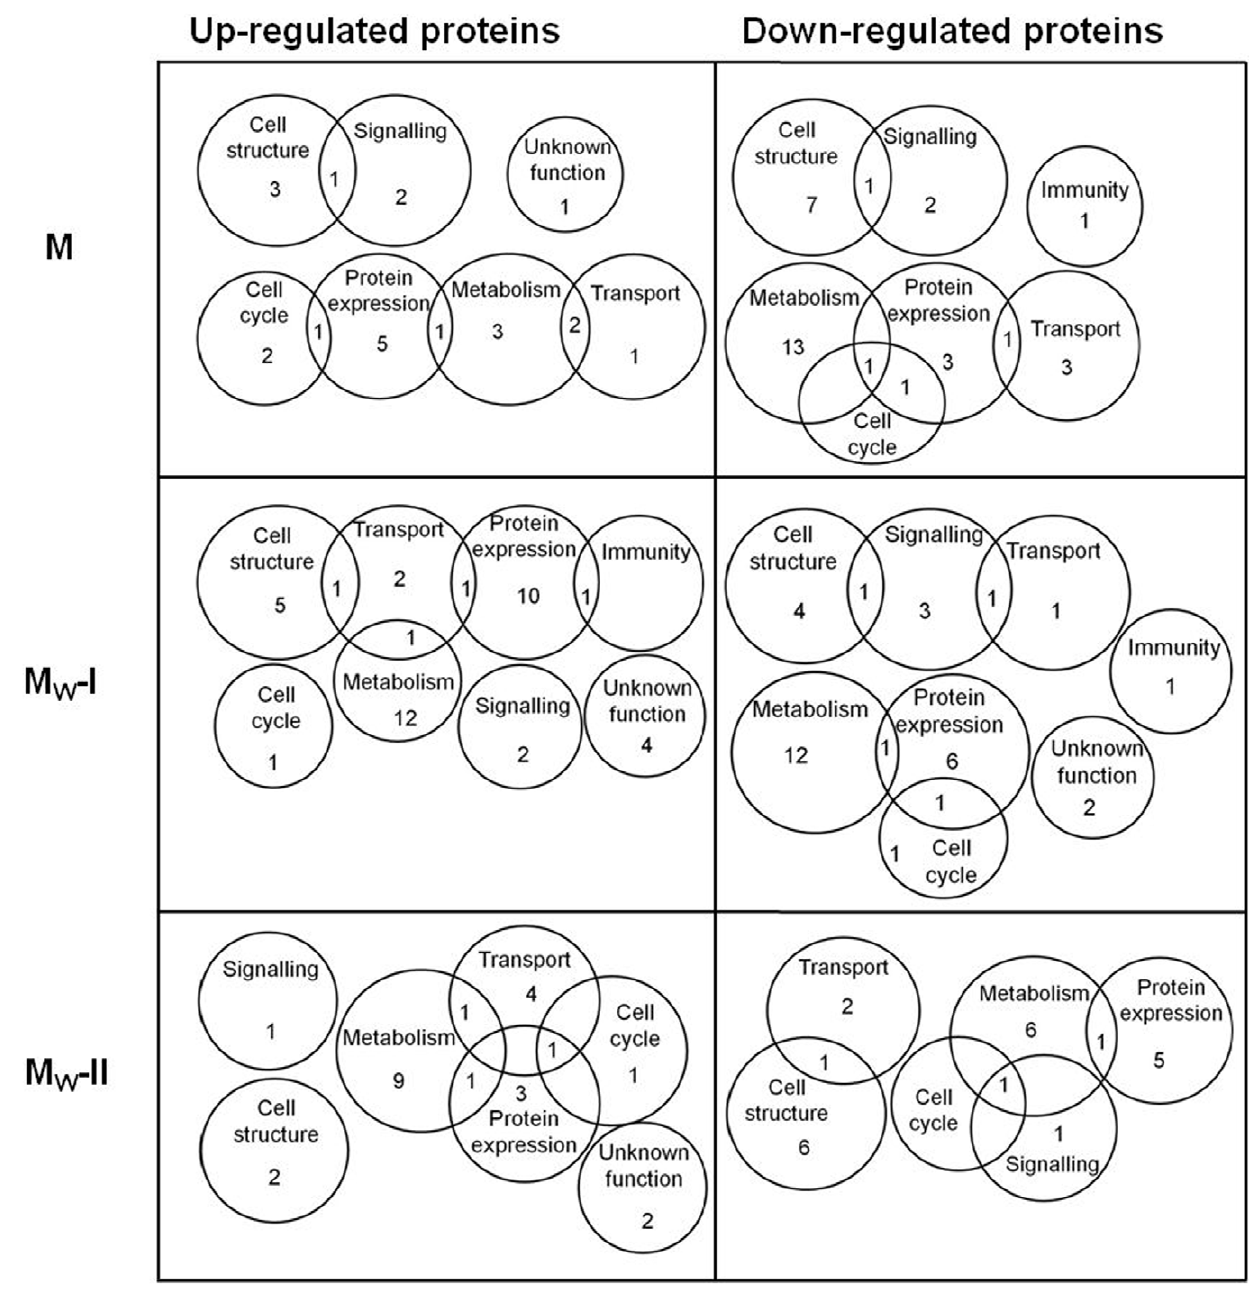
Figure 3. Venn diagrams showing the distribution of myocardial proteins in the cytosolic fraction altered by morphine treatment and withdrawal. Numbers in the individual circles or sectors refer to the number of altered proteins which were determined in the cytosolic fraction isolated from the left ventricles of morphine-treated (M) and morphine-withdrawn for 3 days (M W -I) or 6 days (M W -II) rats. These proteins were arranged according to their function into 16 groups.